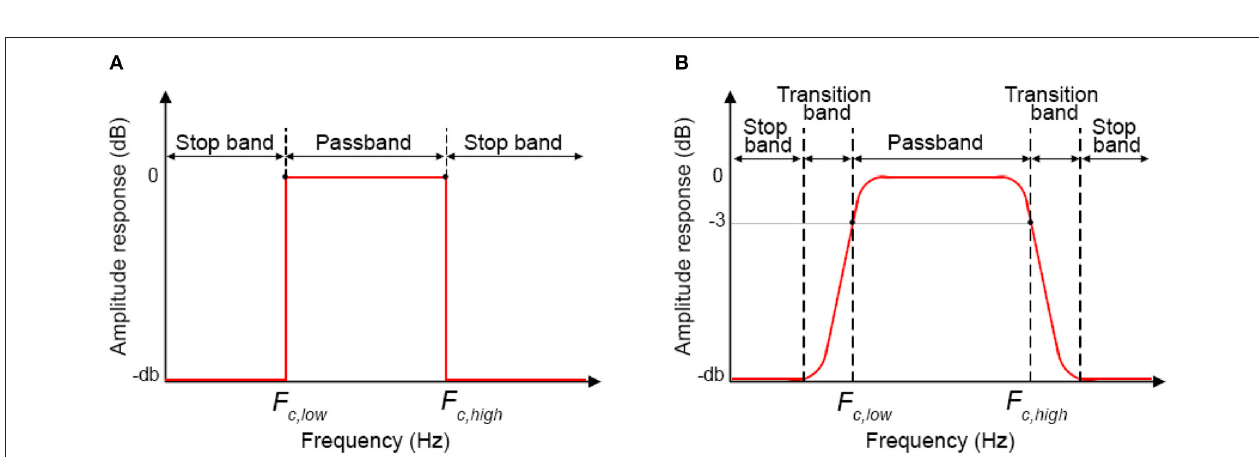
FIGURE 9 | Example of 1 HbO 2 and 1 HbR signals with Amplitude 1 for one channel of a representative participant in the time domain (left panel) and frequency domain (right panel). The PSD transforms the fNIRS signal from the time domain into the frequency domain. This allows the identification of the noise components (heart rate, breathing rate, Mayer waves) and the stimulation component, as shown in the left panel.